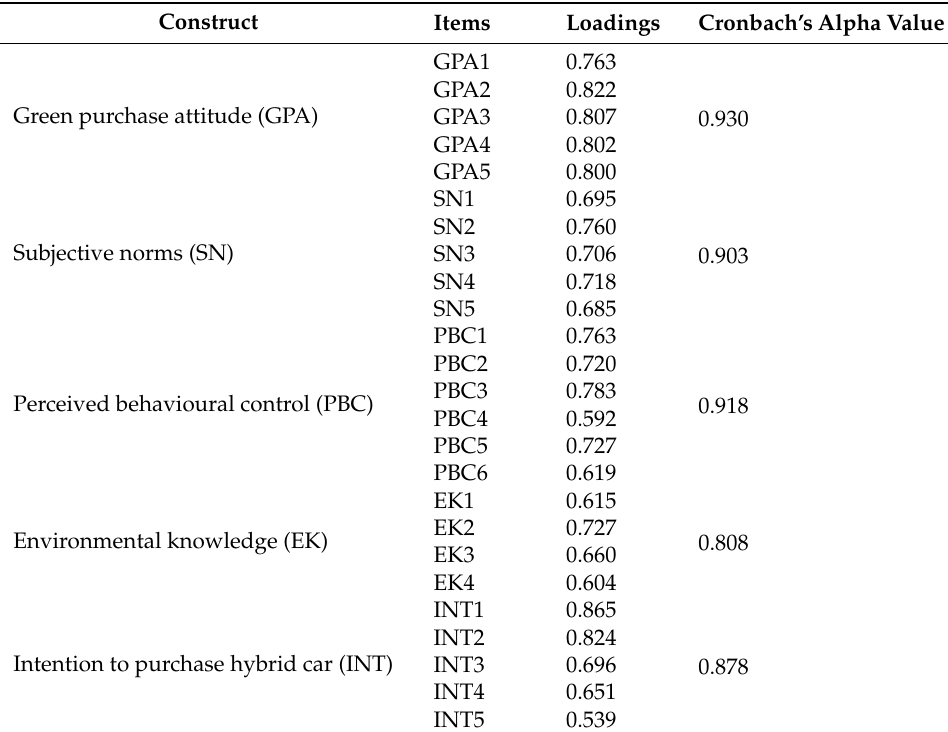
Table 3. Results of the principal component analysis and